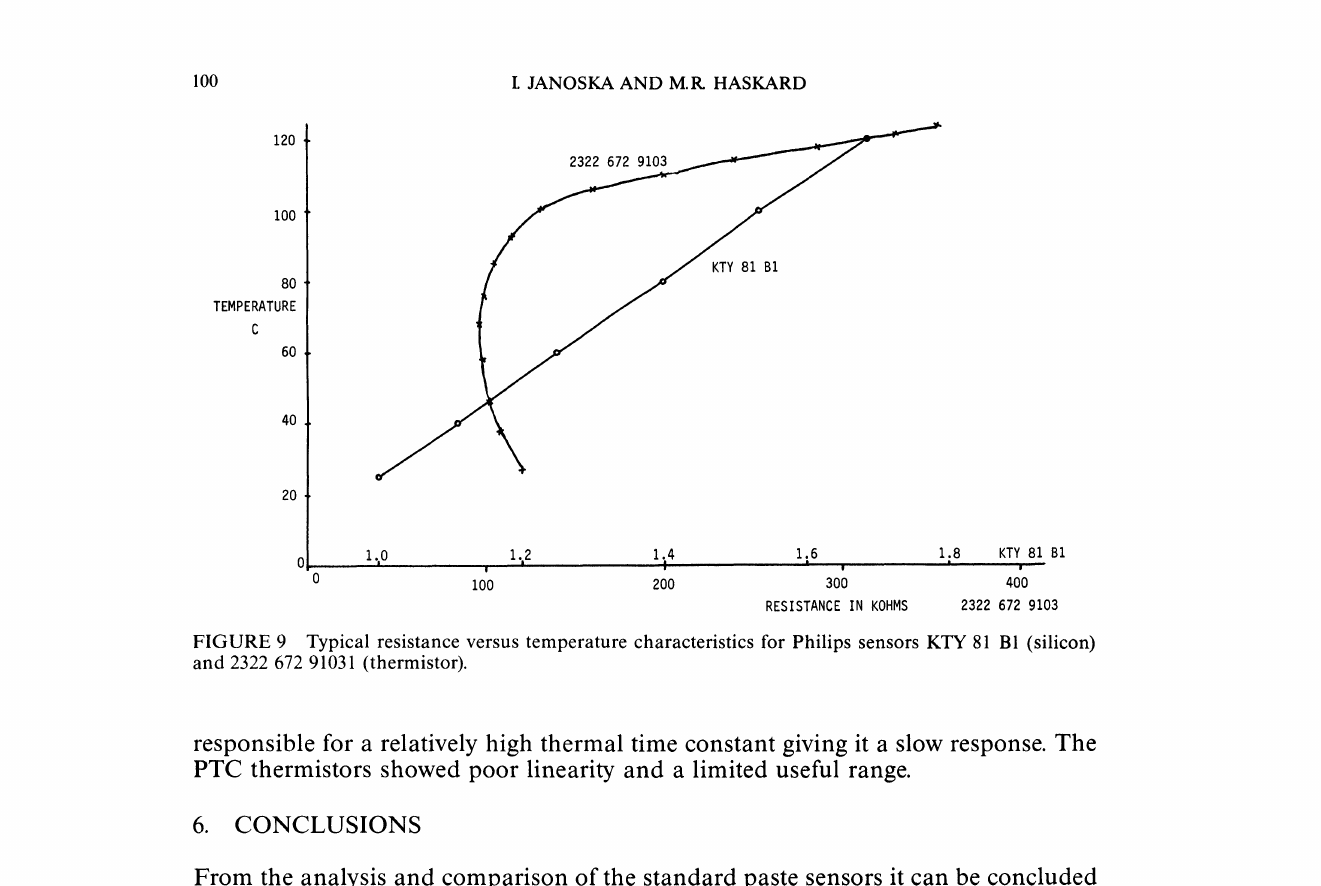
FIGURE 9 Typical resistance versus temperature characteristics for Philips sensors KTY 81 BI (silicon) and 2322 672 91031 (thermistor). responsible for a relatively high thermal time constant giving it a slow response. The PTC thermistors showed poor linearity and a limited useful